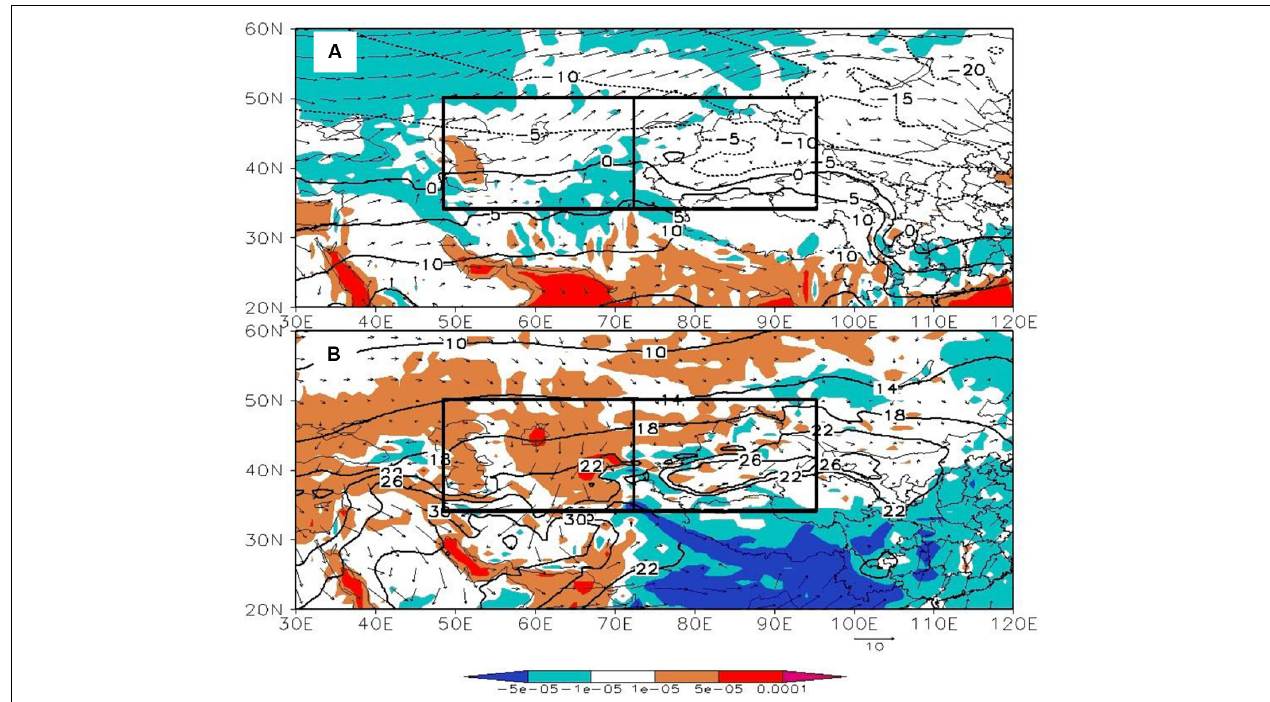
FIGURE 9 | Climatology of wind flows (arrows; units: m s − 1 ) and temperature (contours; units: ◦ C) at 850 hPa and the divergence of the water vapor flux in the atmospheric column (shading; units: kg m − 2 s − 1 hPa − 1 ) in (A) winter and (B) summer from 1979 to 2017. The black boxes denote regions I and II.